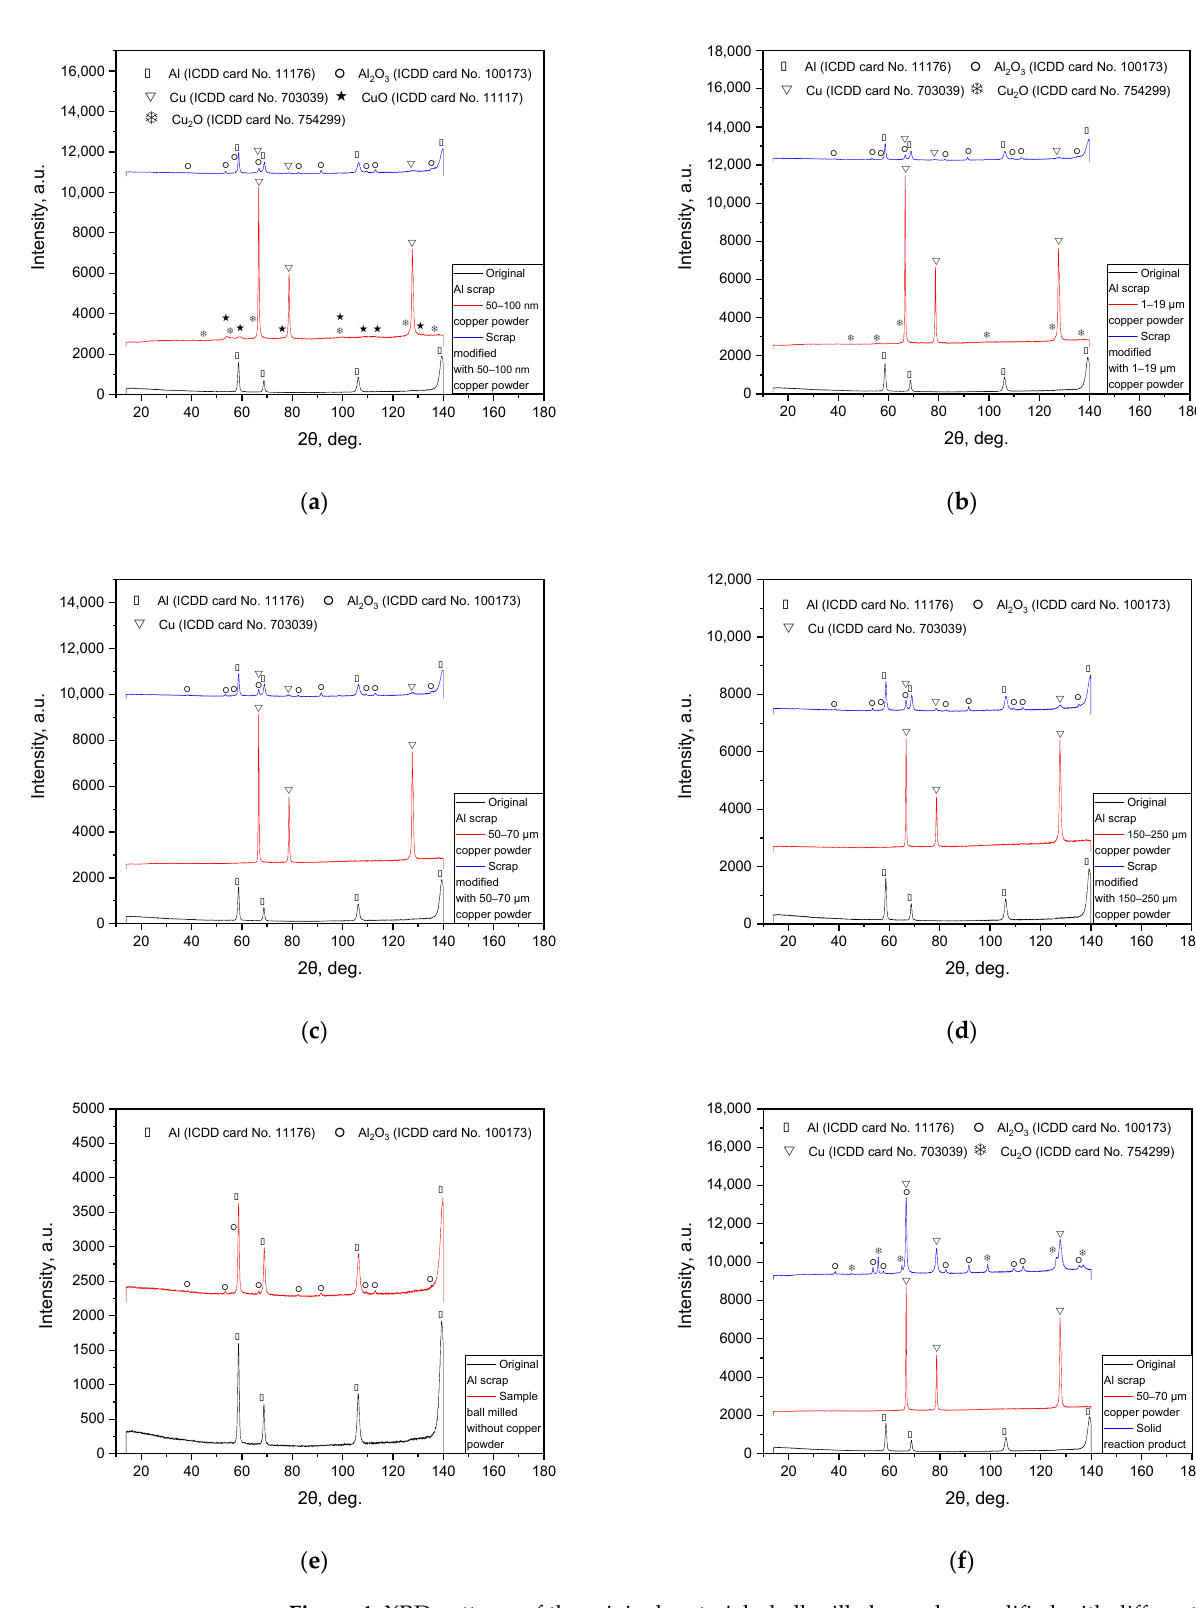
Figure 4. XRD patterns of the original materials, ball milled samples modified with different copper powders, sample ball milled as it was, and filtered solid reaction product: ( a ) 50–100 nm copper powder; ( b ) 1–19 µ m copper powder; ( c ) 50–70 µ m copper powder; ( d ) 150–250 µ m copper powder; ( e ) without copper powder; ( f ) reaction product (from scrap and 50–70 µ m copper powder